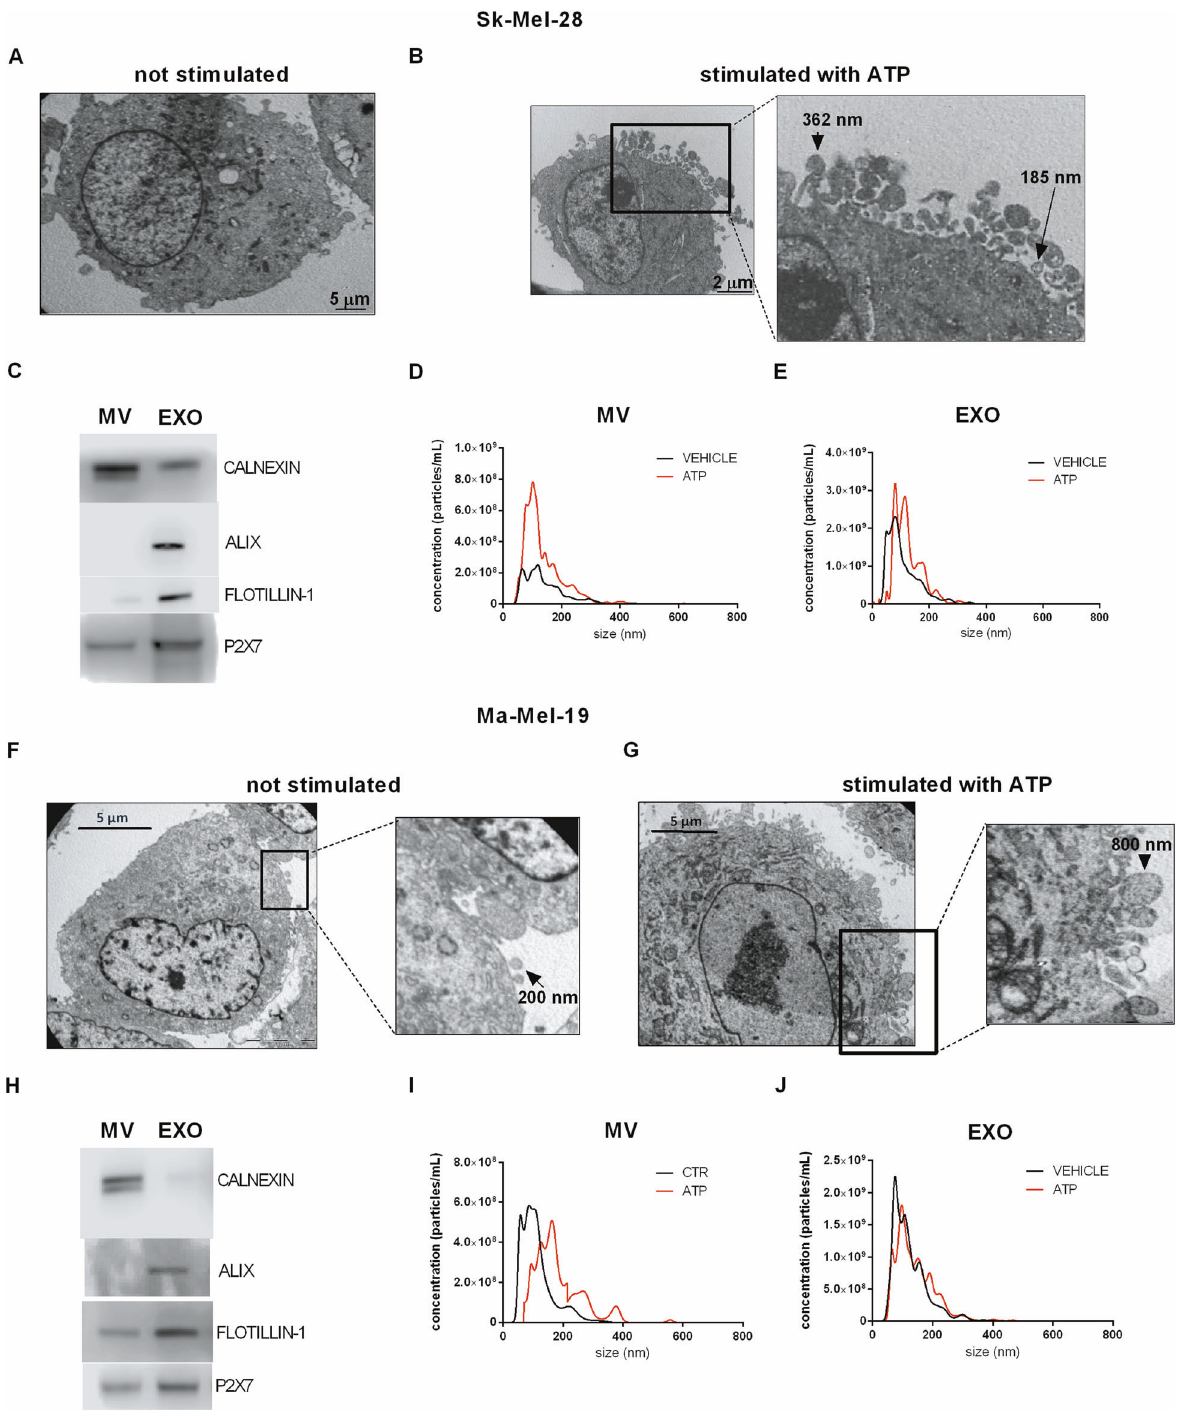
Fig. 6 Characterization of vesicles released from Sk-Mel-28 and Ma-Mel-19 cells. A Representative electron microscopy image of an unstimulated Sk-Mel-28 cell (magni fi cation × 4000). B Representative electron microscopy image of Sk-Mel-28 cell stimulated with 3 mM ATP (magni fi cation × 8000). C Western blot analysis of calnexin (95 kDa), Alix (95 kDa), fl otillin-1 (49 kDa), P2X7 (75 kDa) in MV, and EXO isolated from Sk-Mel-28 cells treated with 3 mMATP. D Representative graphs of size distribution and concentration of MV released from Sk-Mel-28 cells stimulated with a vehicle or ATP. E Representative graphs of size distribution and concentration of EXO released from Sk-Mel-28 cells stimulated with a vehicle or ATP. F Electron microscopy image of an unstimulated Ma-Mel-19 cell (magni fi cation × 4000). G Electron microscopy image of a Ma-Mel-19 cell stimulated with 3 mM ATP (magni fi cation × 4000). H Western blot analysis of calnexin (95 kDa), Alix (95 kDa), fl otillin-1 (49 kDa), P2X7 (75 kDa) in MV, and EXO isolated from Ma-Mel-19 cells treated with 3 m MATP. I Representative graphs of size distribution and concentration of MV released from Ma-Mel-19 cells stimulated with a vehicle or ATP. J Representative graphs of size distribution and concentration of EXO released from Ma-Mel-19 cells stimulated with a vehicle or ATP. Nanosight Analysis of fi ve different videos allowed to obtain data relative to vesicle concentration and